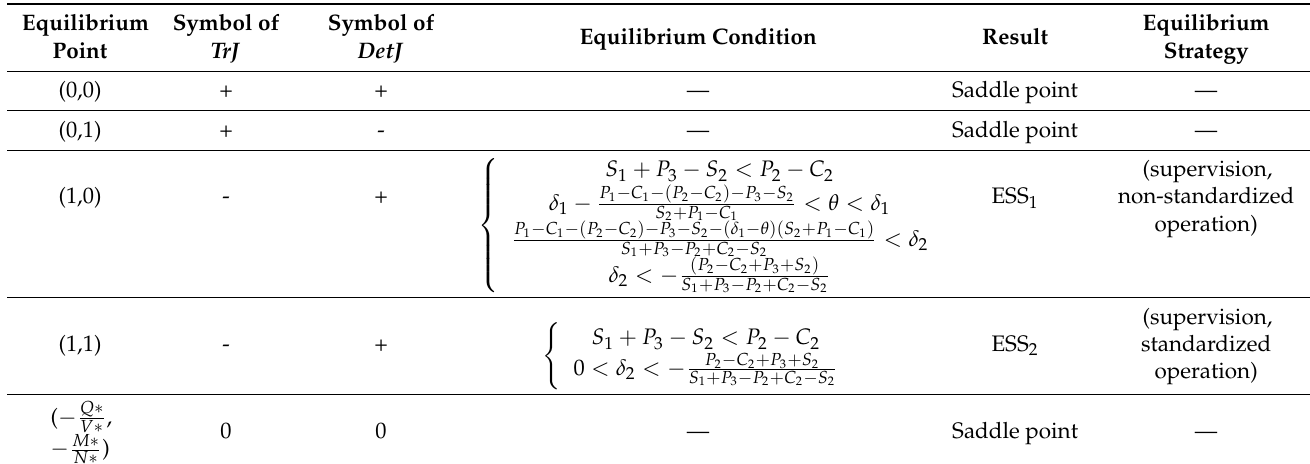
Table 9. Equilibrium point and the value of DetJ and TrJ